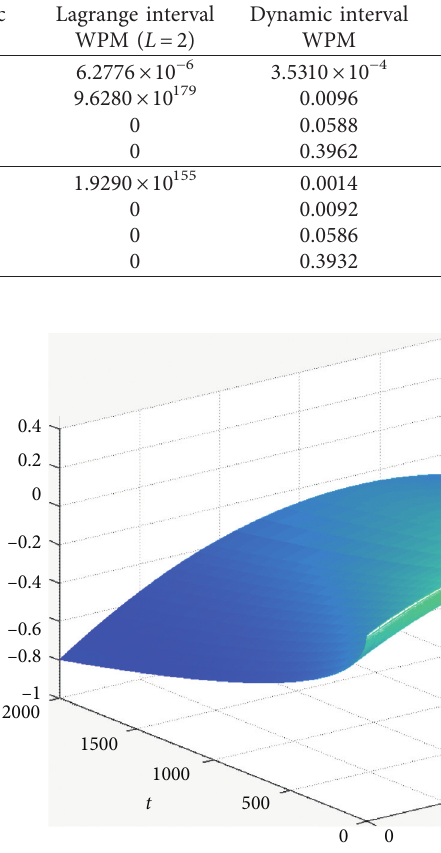
Figure 3: Trend of the solution with t